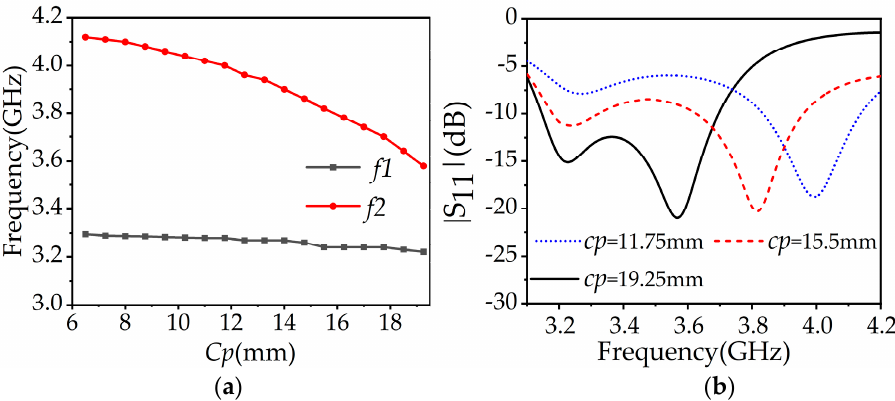
Figure 5. ( a ) Two resonant frequencies; ( b ) |S 11 |s under different lengths of Cp of Antenna III.